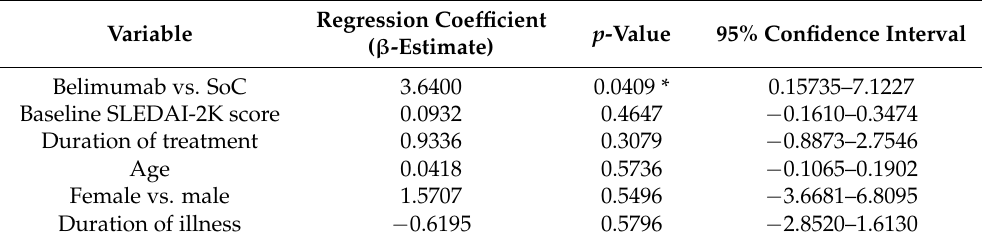
Table 3. Multiple regression analysis for the relationship between the SLEDAI-2K score difference (baseline SLEDAI-2K score–follow-up SLEDAI-2K score) and the use of belimumab versus the standard of care (SoC) for SLE treatment. Regression Coefficient p -Value 95% Confidence Interval Variable ( β -Estimate) Belimumab vs. SoC 3.6400 0.0409 * 0.15735–7.1227 Baseline SLEDAI-2K score 0.0932 0.4647 − 0.1610–0.3474 Duration of treatment 0.9336 0.3079 Age 0.0418 0.5736 Female vs. male 1.5707 Duration of illness −